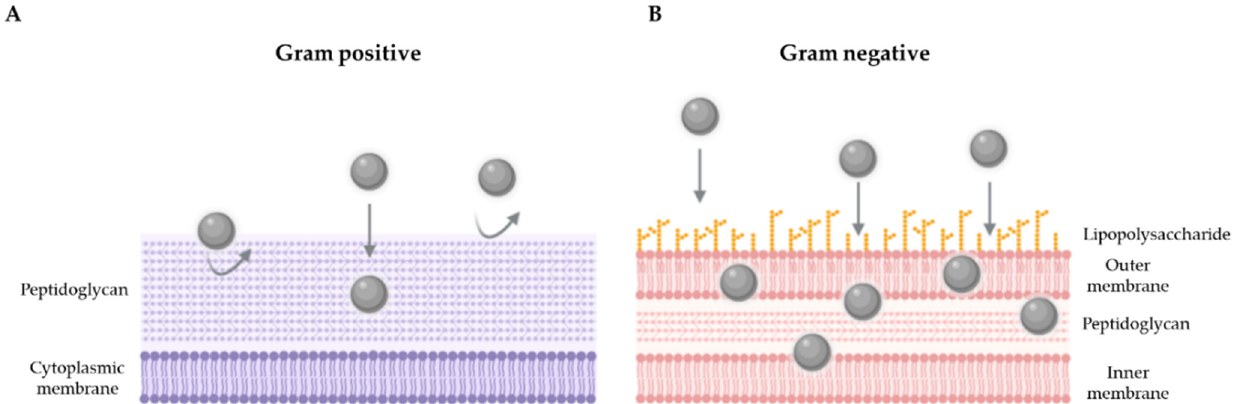
Figure 5. Hypothetical model showing the interaction of AgNPs against Gram-positive ( A ) and Gram-negative ( B )